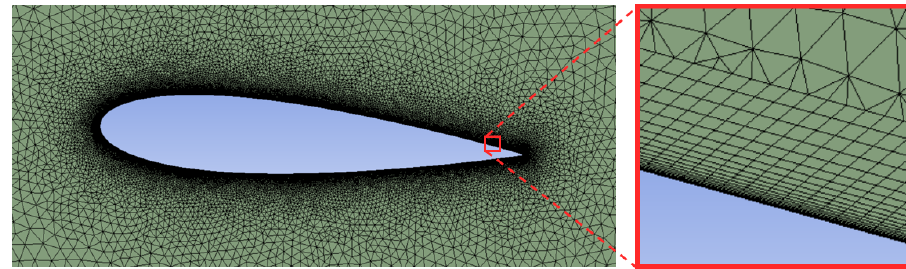
Figure 2. Inflation layer meshing around a foil.